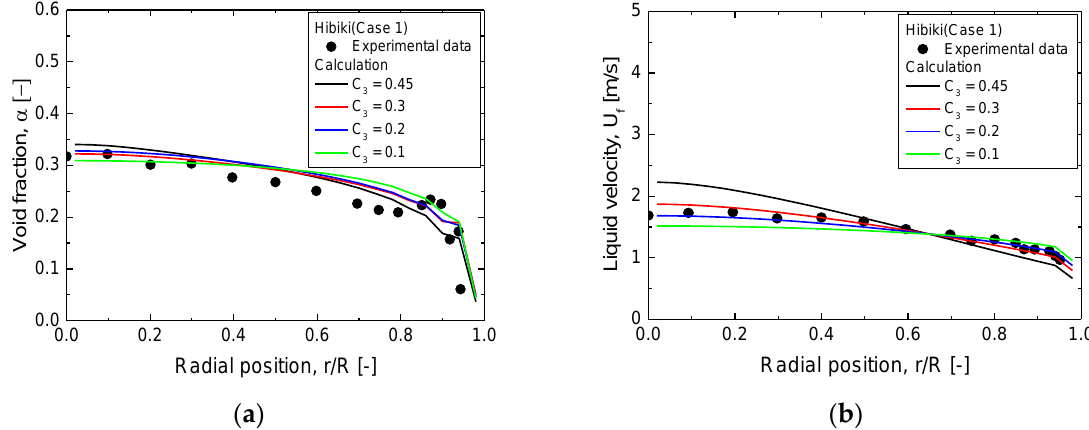
Figure 1. Prediction of radial distribution of ( a ) void fraction, and ( b ) liquid velocity by the different coefficients of Troshko and Hassan’s BIT model.